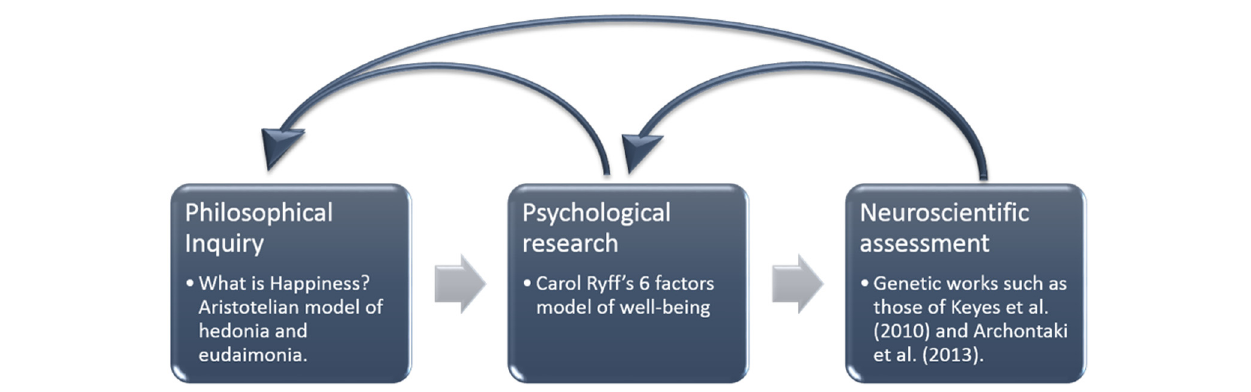
FIGURE 2 | Happiness as an example of the way in which a neuroscientific approach may shed light on longstanding philosophical